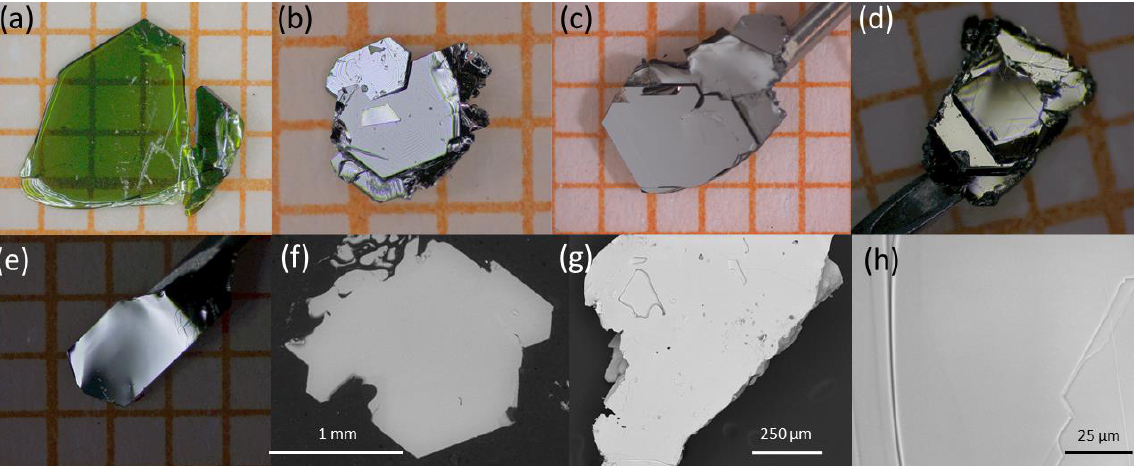
Figure 1. Examples of single crystals grown by the chemical vapor transport ( a ) Mn 2 P 2 S 6 , ( b ) (Mn 0.7 Ni 0.3 ) 2 P 2 S 6 , ( c ) (Mn 0.5 Ni 0.5 ) 2 P 2 S 6 , ( d ) (Mn 0.3 Ni 0.7 ) 2 P 2 S 6 and ( e ) Ni 2 P 2 S 6 ; cell scale is 1 mm, SEM-images of ( f ) (Mn 0.3 Ni 0.7 ) 2 P 2 S 6 , ( g ) (Mn 0.5 Ni 0.5 ) 2 P 2 S 6 , and ( h ) (Mn 0.7 Ni 0.3 ) 2 P 2 S 6 SEM-backscattered electron (BSE) mode.